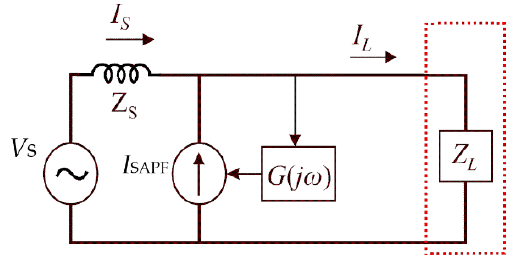
Figure 2. Compensation issues related to the shunt active power filter (SAPF).